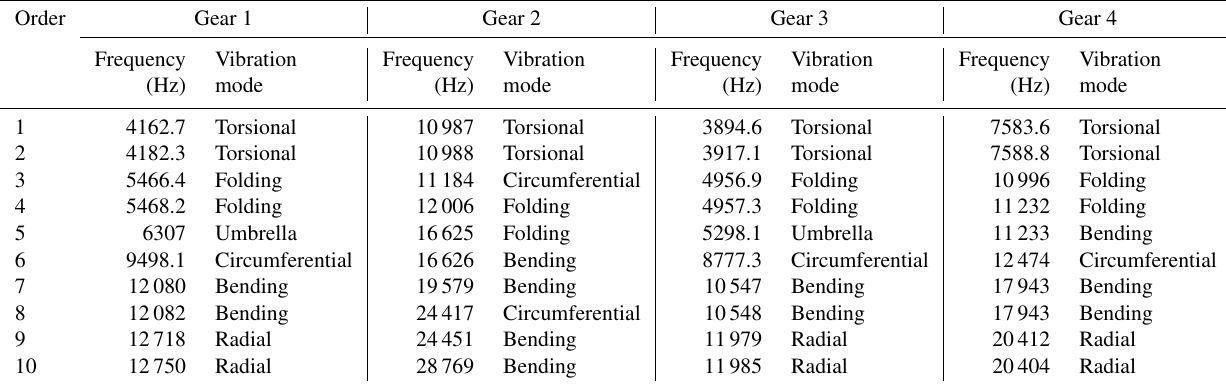
Table 4. Natural frequencies and vibration modes of bevel gears.